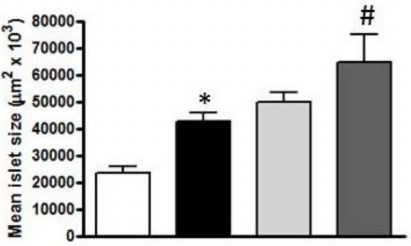
Figure 4. Mean islet size ( µ m 2 × 10 3 ) of rats at 20 weeks of age. The analysis was made in two to four slices per animal, which measured a minimum of 100 islets per treatment under a 40 × objective. Experimental groups: control Zucker lean drank water (ZLR; white bar), control Zucker fatty rats (ZFR, black bar), ZFR treated for 12 weeks (from week eight to week 20) with 750 mg/kg/day of egg white hydrolyzed with pepsin (light grey bar) and ZFR treated for 12 weeks with 750 mg/kg/day of egg white hydrolyzed with aminopeptidase (dark grey bar). Bars show means ± SEM. Student t -test was used. * p < 0.05 vs. ZLR, # p < 0.05 vs. control ZFR ( n ≥ 9 for all